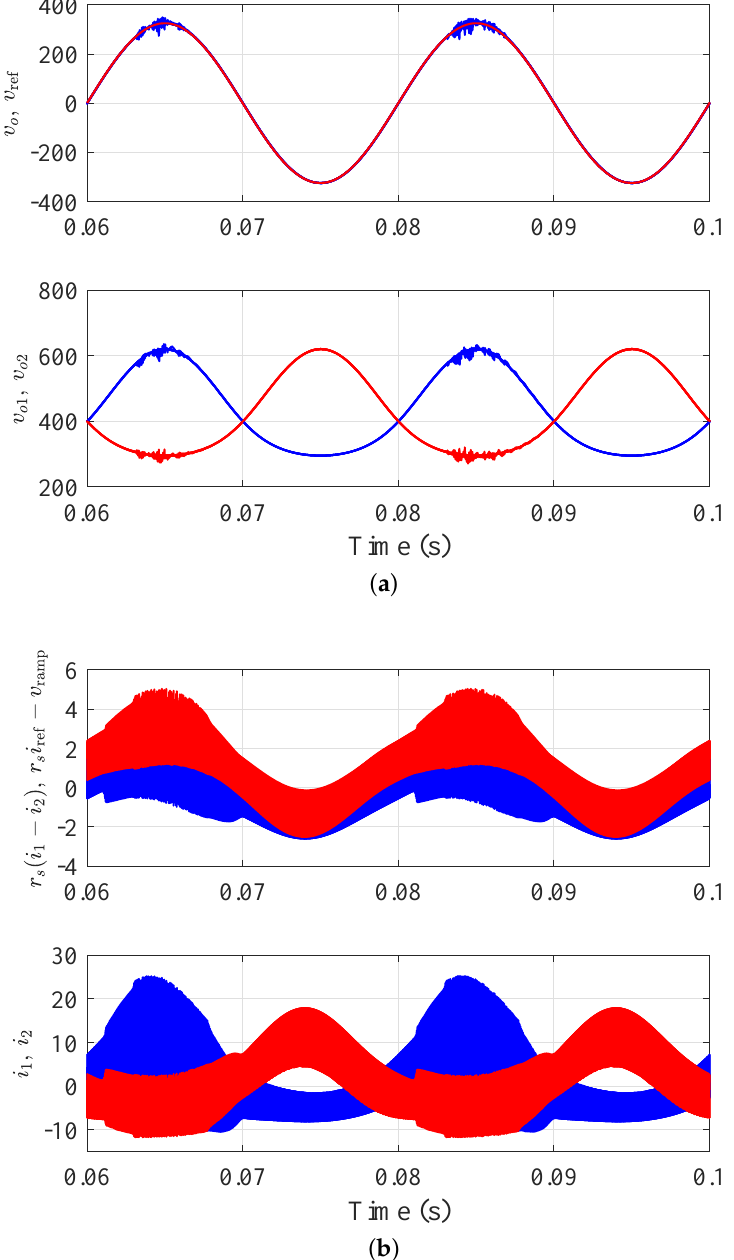
Figure 4. Steady-state response of boost inverter with k p = 0.8 and V M = 2 V. ( a ) Capacitor voltages v o 1 and v o 2 , output and reference voltages v o and v ref . ( b ) Inductor currents i 1 and i 2 and control signals r s ( i 1 i 2 ) and r s i ref v ramp . For each subplot, traces correspond to the shown voltages in [V] and currents − − in